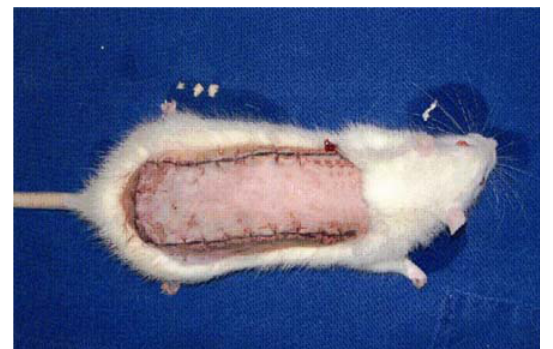
FIGURE 4 – Suture with 4-0 nylon stitches after the flap was raised and a plastic barrier was